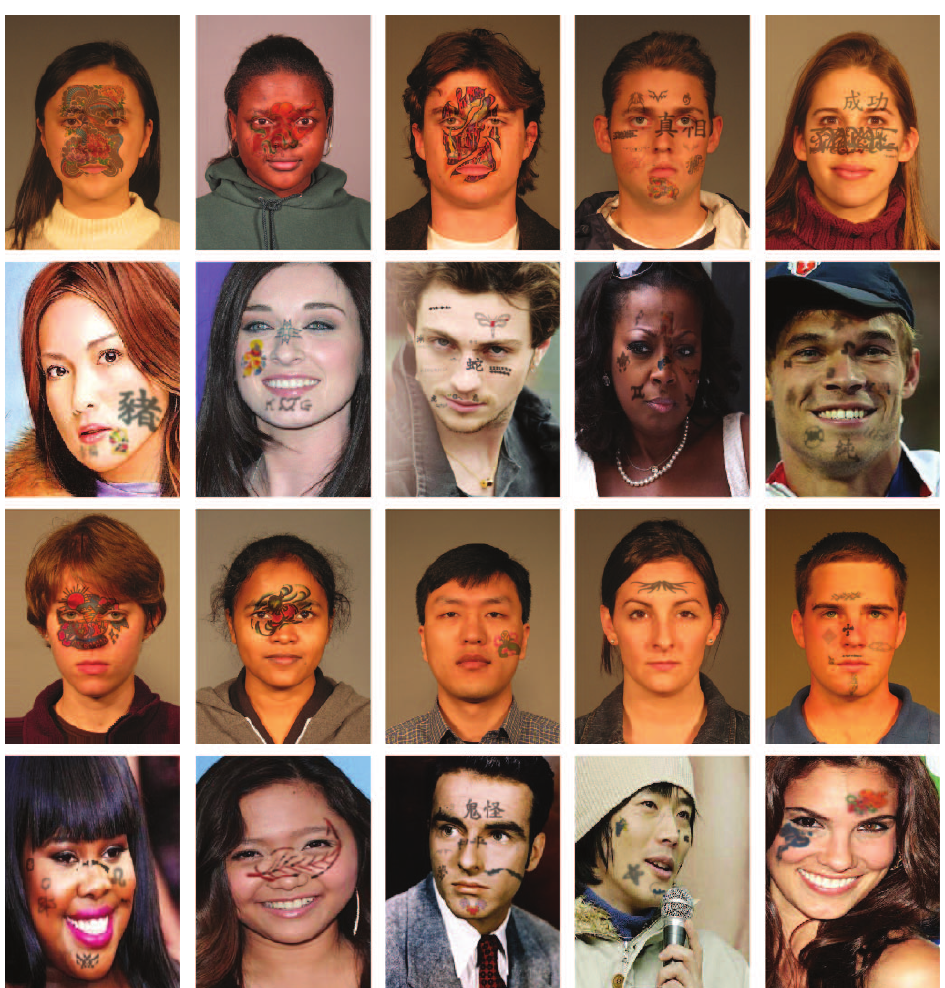
Figure 11. Examples of generated facial images with